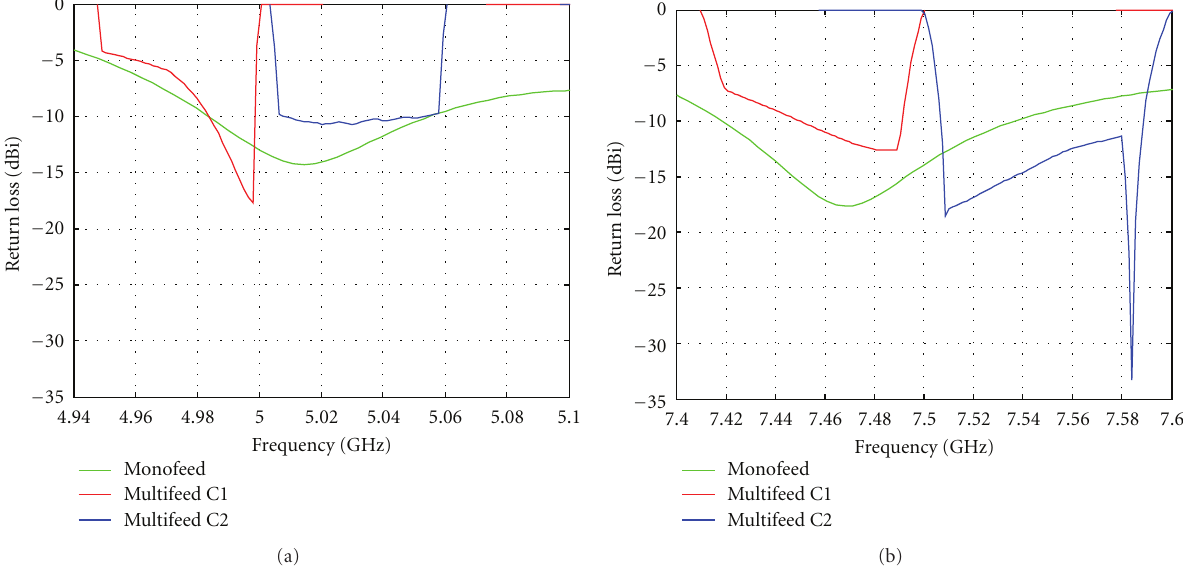
Figure 19: Return loss of the system inside both channels at f L (a) and f H